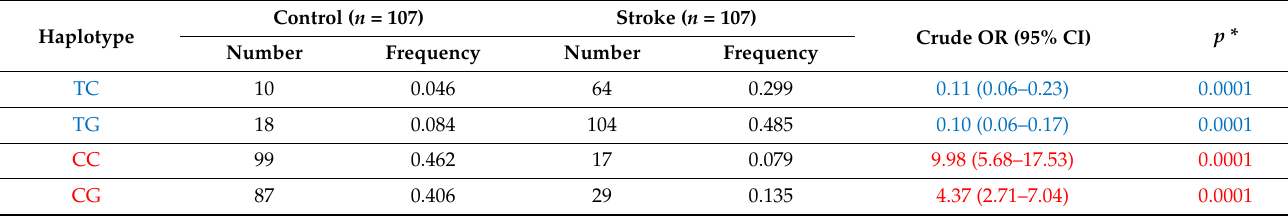
Table 9. Distribution of haplotypes of the c.1823C > T (rs2297518) and c.-227G > C (rs10459953) polymorphisms in the NOS2 gene and odds ratio (OR) with 95% confidence interval (95% CI) in patients with stroke and controls.